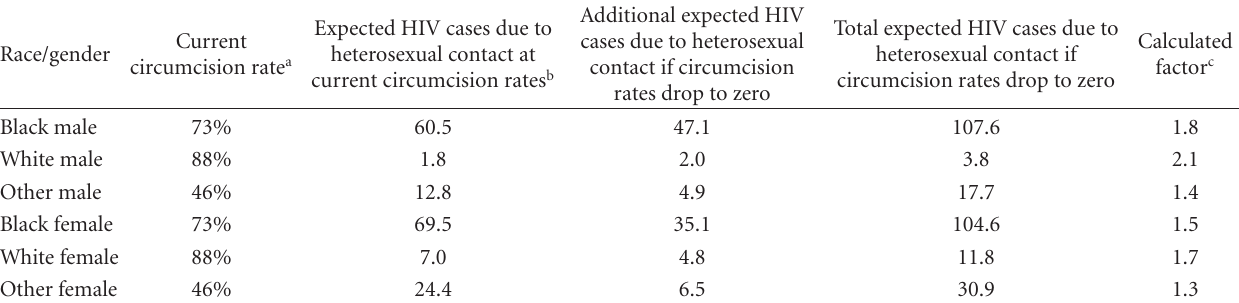
Table 3: Explanation of calculated increased race/gender specific HIV